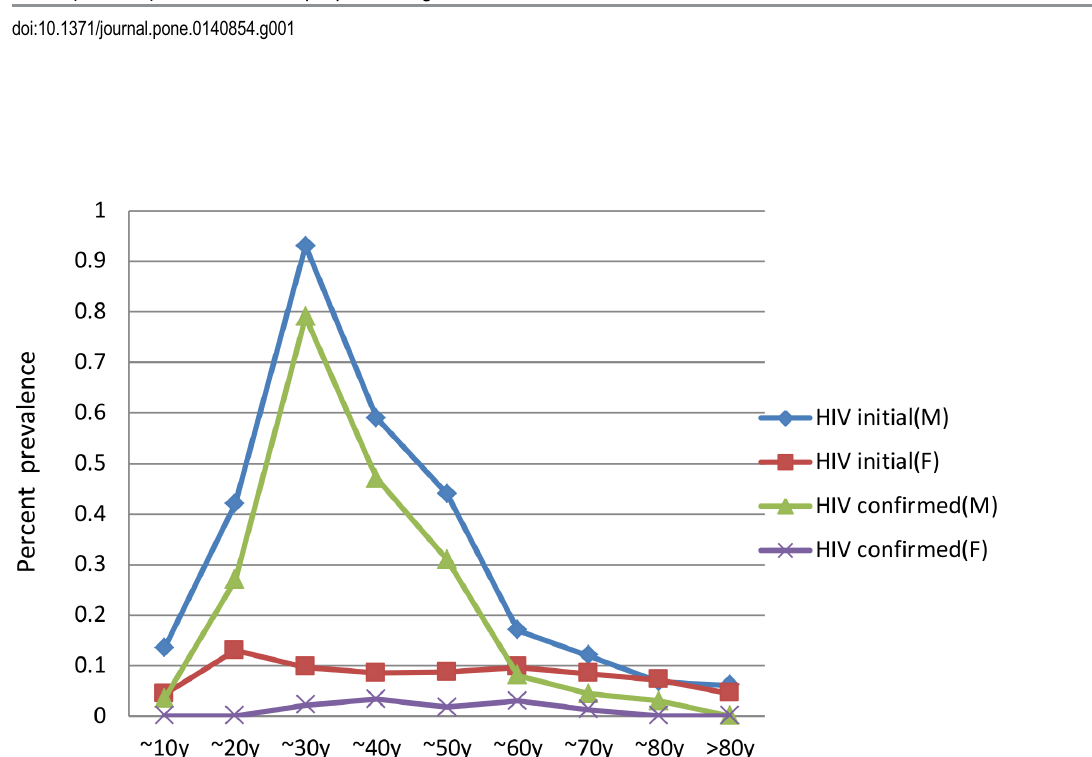
Fig 2. Sex-related Differences in the Seroprevalence of HIV According to Age. HIV, human immunodeficiency virus; M, male; F, female.